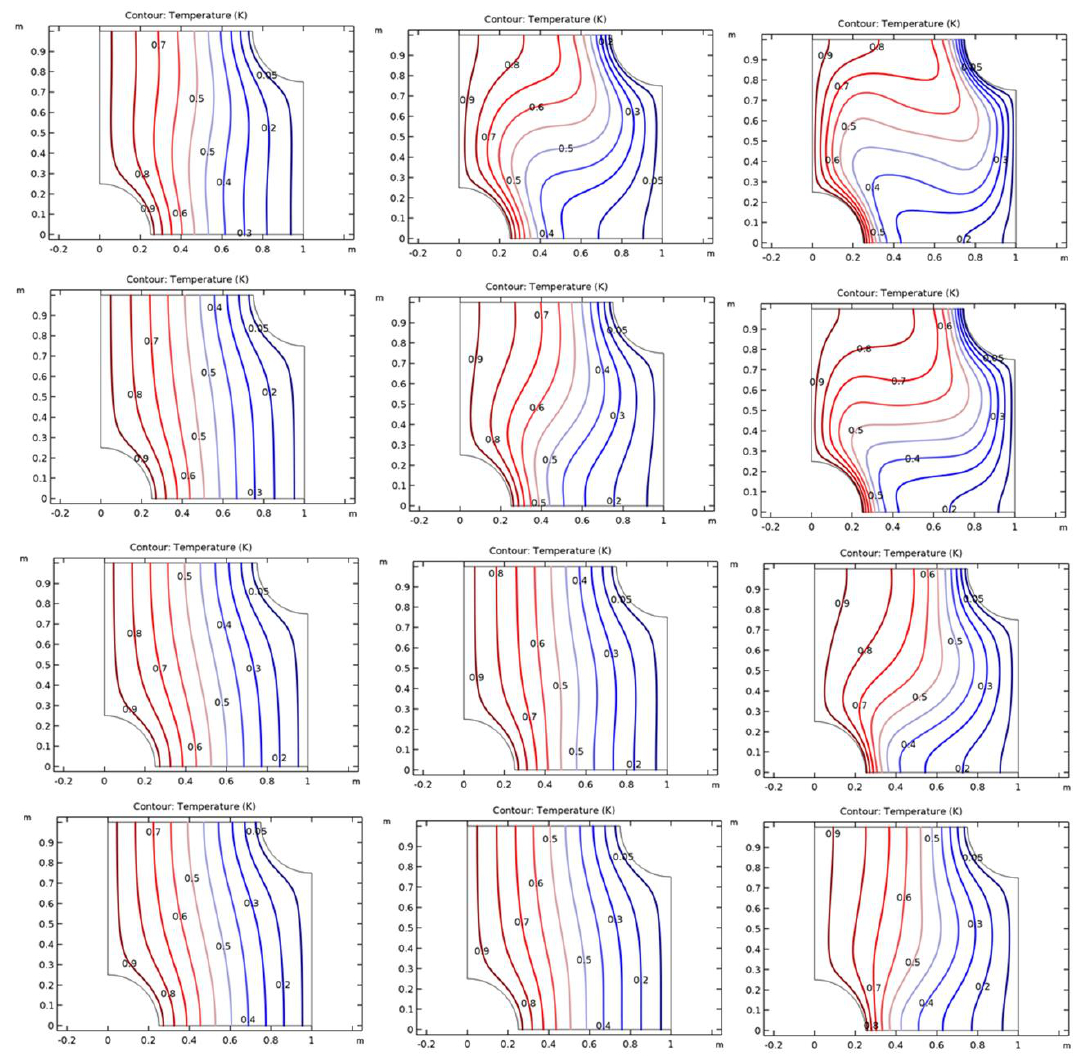
Figure 3. E ff ect of Hartmann number and Rayleigh number on the isotherm Figure 3. Effect of Hartmann number and Rayleigh number on the isotherm contours.